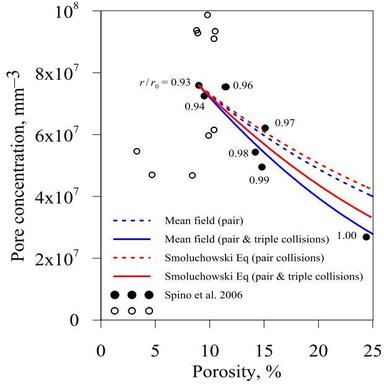
Comparison of calculation results for the dependence of pore density on the local porosity, obtained with or without consideration of triple pore collisions, with the experimental data of Spino et al.. Open markers corresponding to measurements at r=r0 <0:95 and demonstrating a wide scatter of experimental data are excluded from consideration.